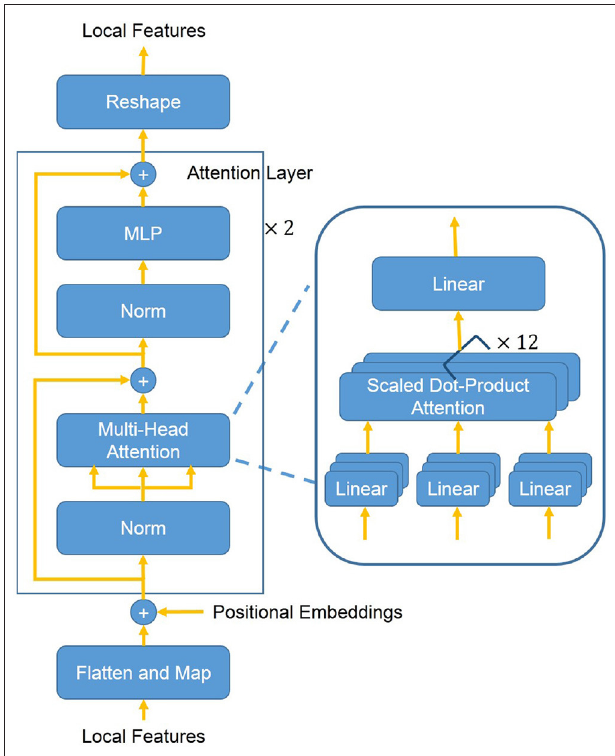
FIGURE 3 | The overall structure of the position attention block. First, the 3D local features are flattened and mapped into a latent d -dimensional embedding space. Moreover, learnable positional embeddings are added to the feature embeddings. Then added embeddings are put into a stack of L = 2 identical attention layers. The attention layer mainly consists of a MSA mechanism and a MLP. The MSA consists of M = 12 concatenated “Scaled Dot-Product Attention”. At last, the flattened features are reshaped back into 3D